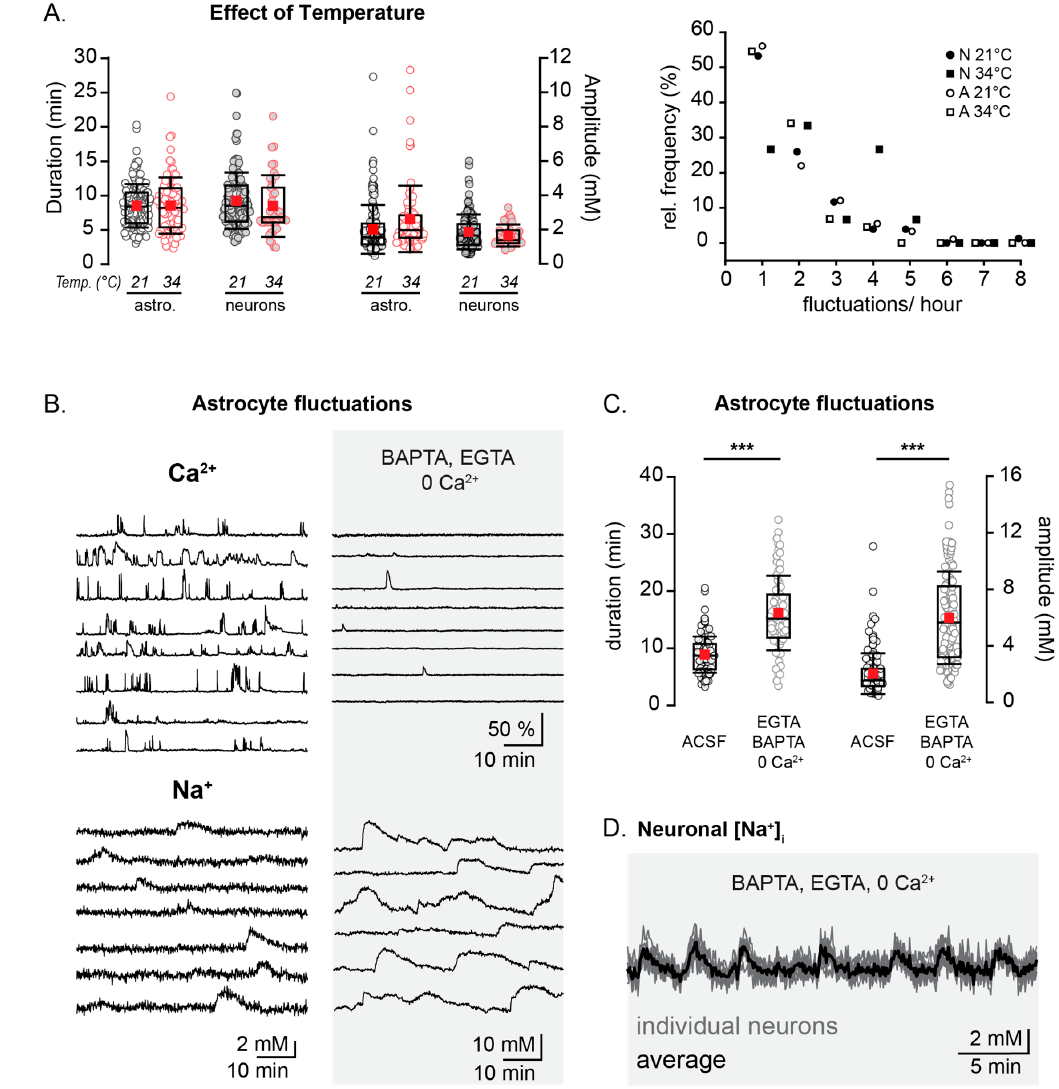
Figure 4. Temperature dependence and interrelation with spontaneous Ca 2+ -signaling. ( A ) Left: the duration and amplitude of neonatal astrocytic and neuronal Na + fluctuations at 21 °C (black) and 34 °C (red). Right: the relative frequency distribution plot of neonatal Na + fluctuations at 21 °C (neurons- black circles, astrocytes- white circles) and 34 °C (neurons- black squares, astrocytes- white squares). ( B ) Example traces from individual astrocytes in Ca 2+ imaging experiments (top) and during Na + imaging (bottom), both in ACSF (left) and in the presence of a Ca 2+ -chelated solution (0 Ca 2+ , ACSF containing 500 µM of BAPTA-AM and 1 mM of EGTA) (right). ( C ) Box plots illustrating the increase in the astrocytic Na + fluctuation amplitudes after the chelation of Ca 2+ . ( D ) Traces showing the Na + fluctuations in several individual neurons (grey) and an averaged trace (black) in a Ca 2+ -chelated solution. *** p < 0.001.